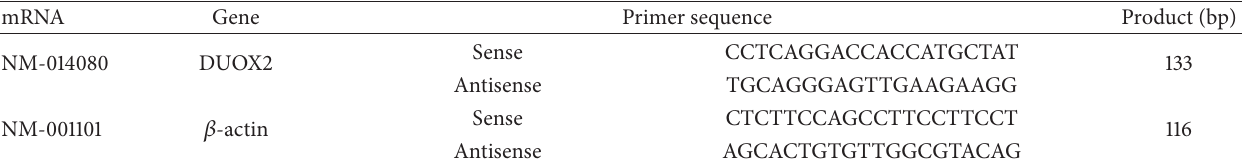
Table 2: Primers sequence.